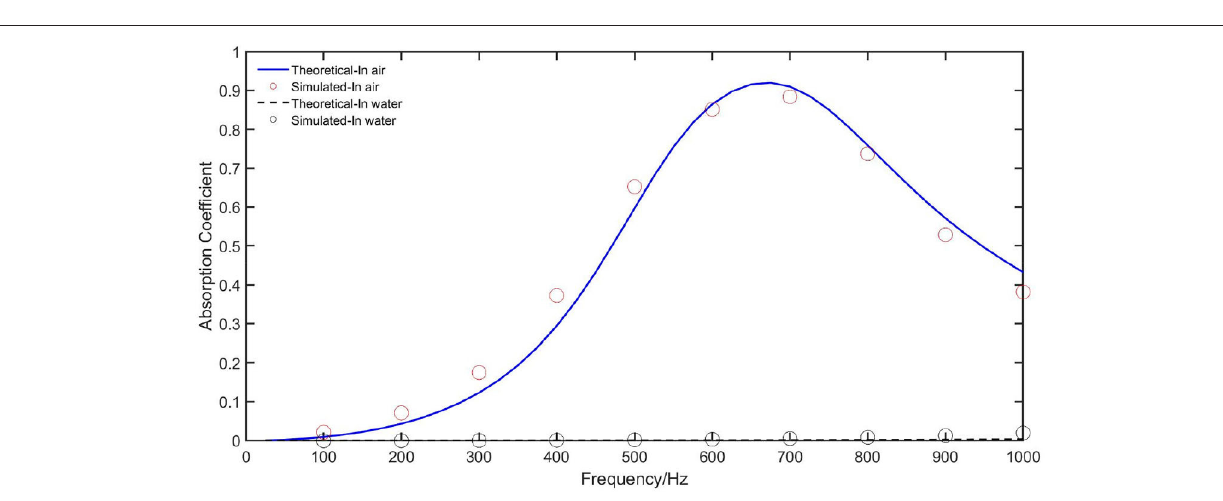
PML and acoustic incident field. The incident directions studied for the acoustic waves are 0 ◦ , 30 ◦ , 45 ◦ , 60 ◦ , and 75 ◦ . The yellow part in Figure 5A is rubber and the blue part is aluminum, which represents the panels with corrugation plates and partition boards, respectively. The periodic condition is also set on the boundary of the colored parts to simulate the